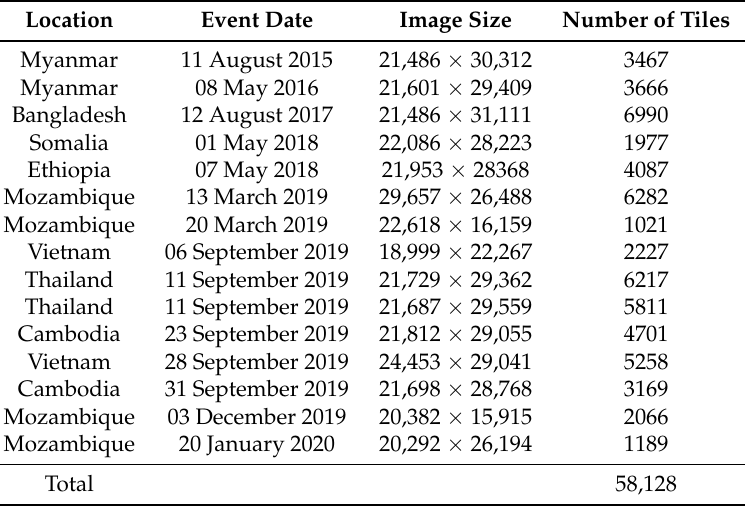
Table 1. Location, event date and image size for each analysis in the UNOSAT Flood Dataset. Due to the very large size of the satellite images, a tiling process was needed (as explained in Section 2.3). Therefore the number of tiles of size 256 × 256 pixels is also